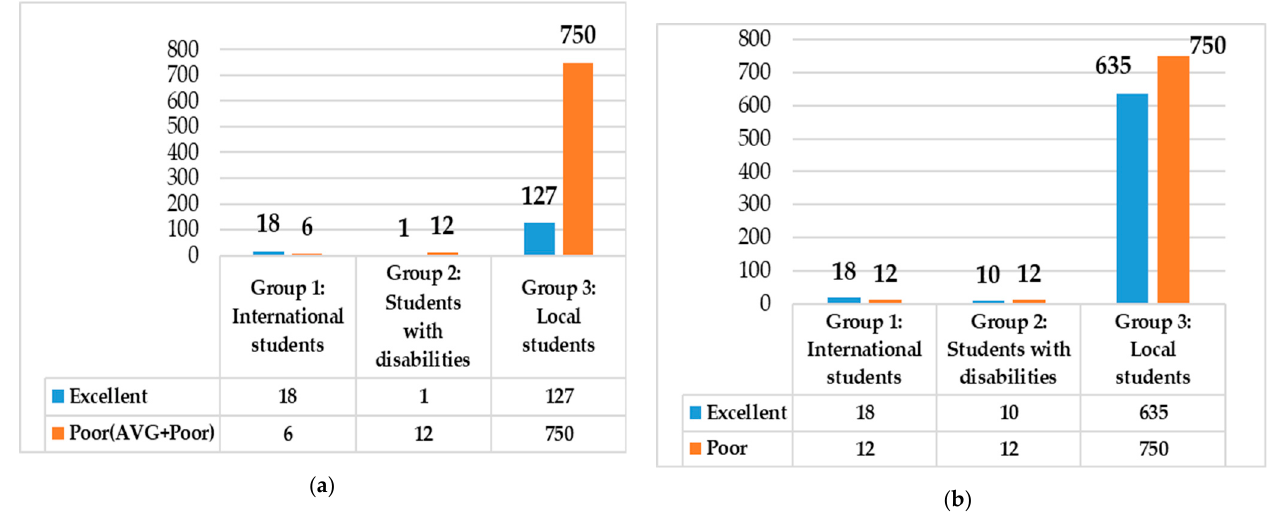
Figure 5. Numbers of samples in each group: ( a ) Case 2: MFC; ( b ) Case 3: ROM.